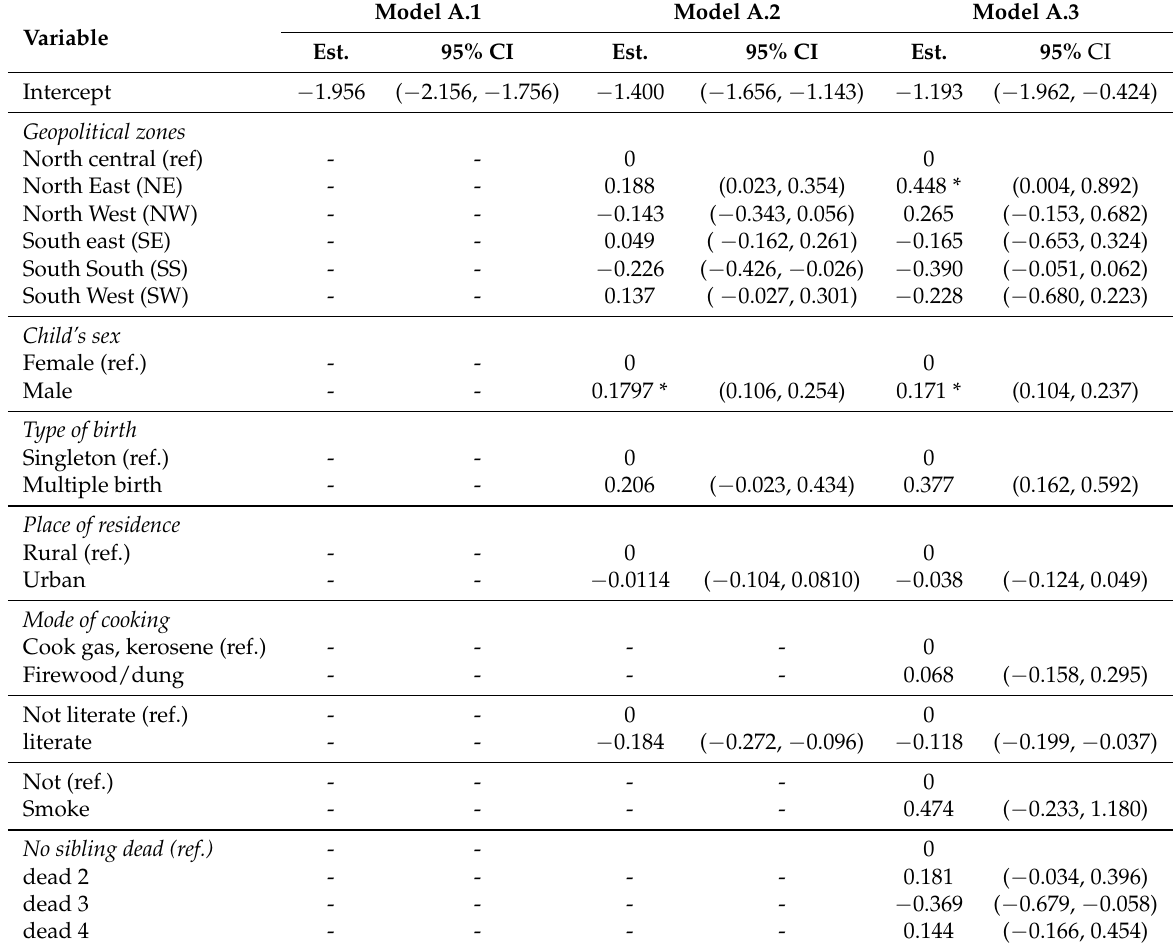
Table 6. Summary of three binary logistic